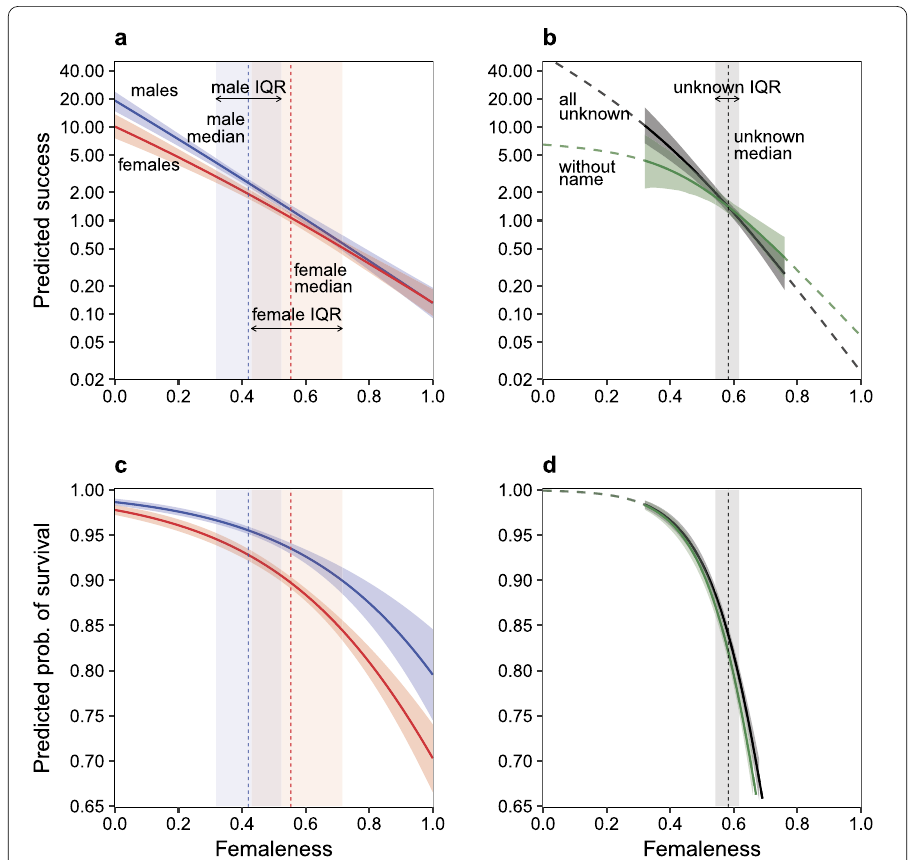
Figure 9 Marginal predictions for femaleness by gender category from model 1 from Fig. 8 of success and survival, with fixing all other variables at their means. Panels ( a ) and ( c ) uses data for males and females, panels ( b ) and ( d ) uses data of users with unknown gender. Prediction is only shown for the observed range of femaleness. Vertical dashed lines indicate medians of femaleness, and shaded vertical bars show the interquartile range